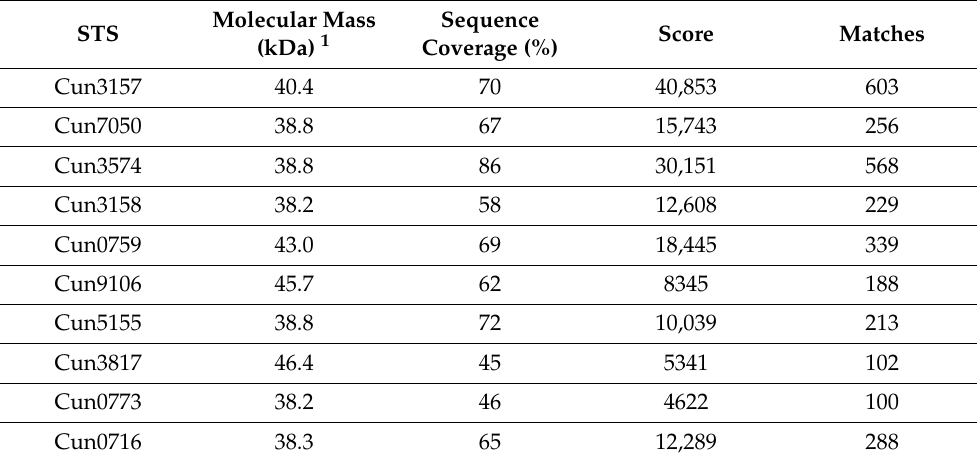
Table 1. Results of peptide mass